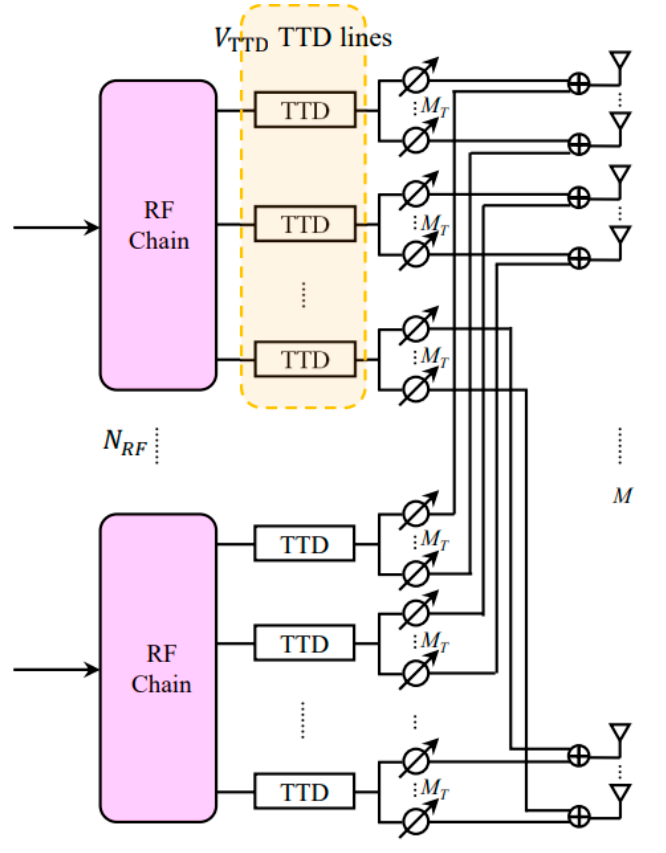
Figure 13. Diagram of the proposed analog beamforming design with true time delay lines [59].